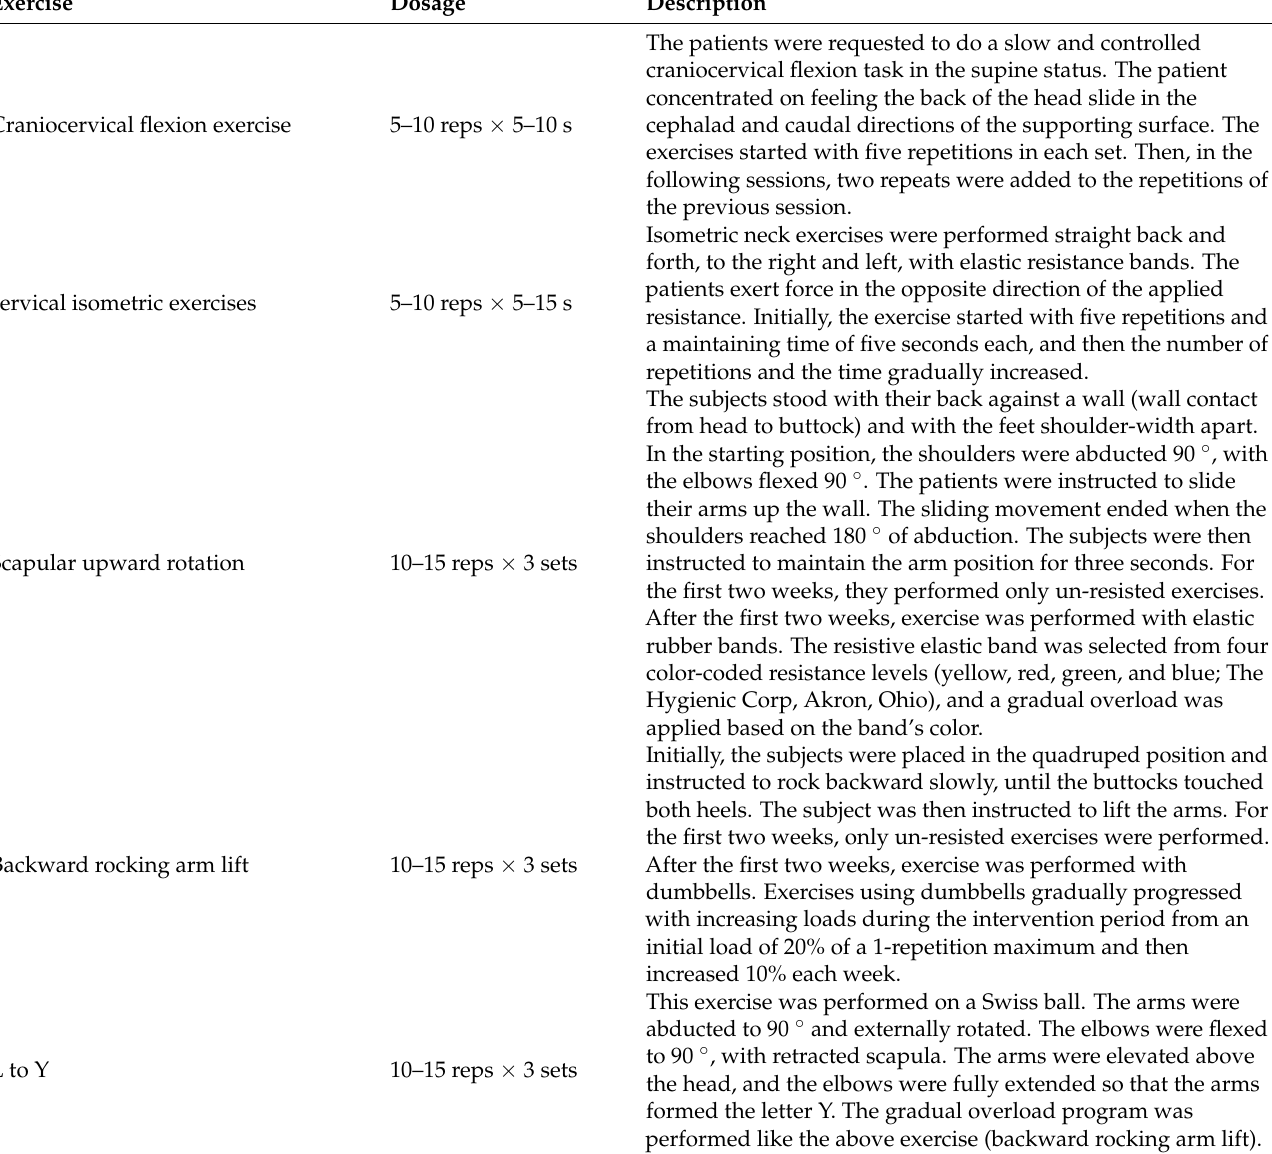
Table 1. Description of the exercises used in the therapeutic exercises